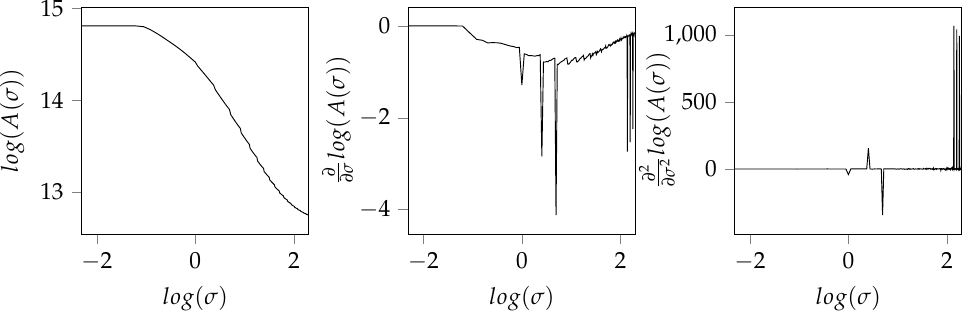
Figure 1. First- and second-order derivatives of the area relation calculated by